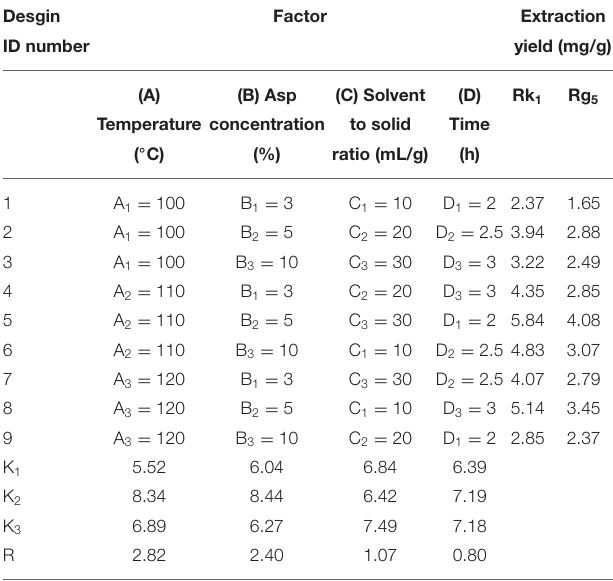
TABLE 2 | Orthogonal test design and results.